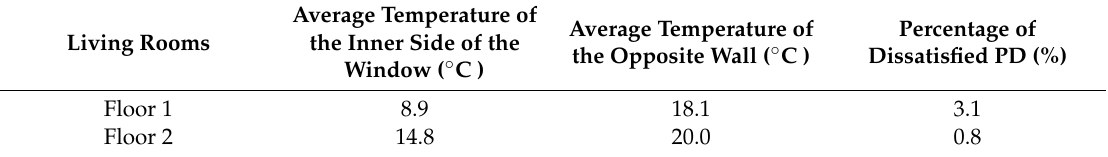
Table 6. PD temperatures and values obtained in living rooms of both studied